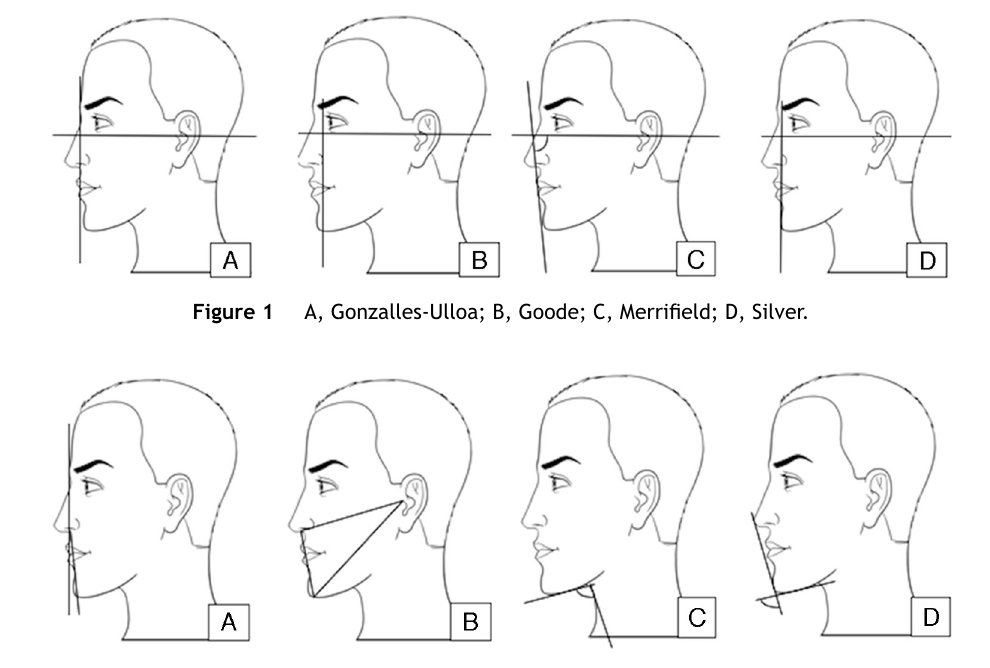
Figure 2 A, Legan; B, Gibson & Calhoun; C, Cervicomental angle; D, Mentocervical